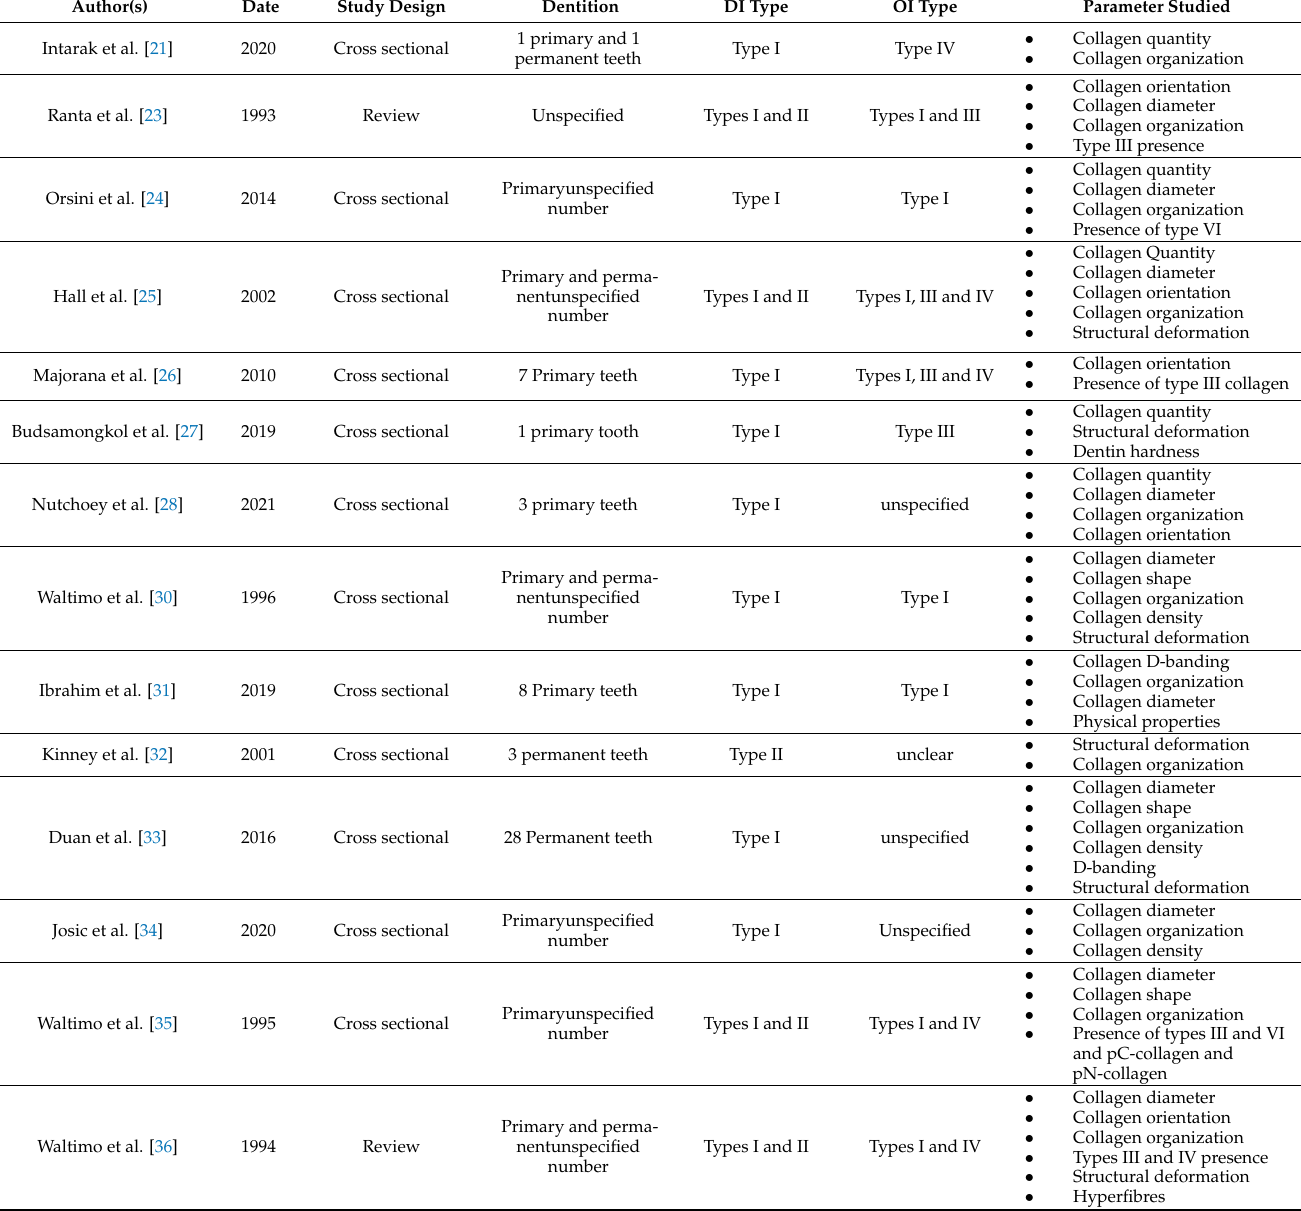
Table 3. Included studies, date of publication, type of OI and collagen parameter